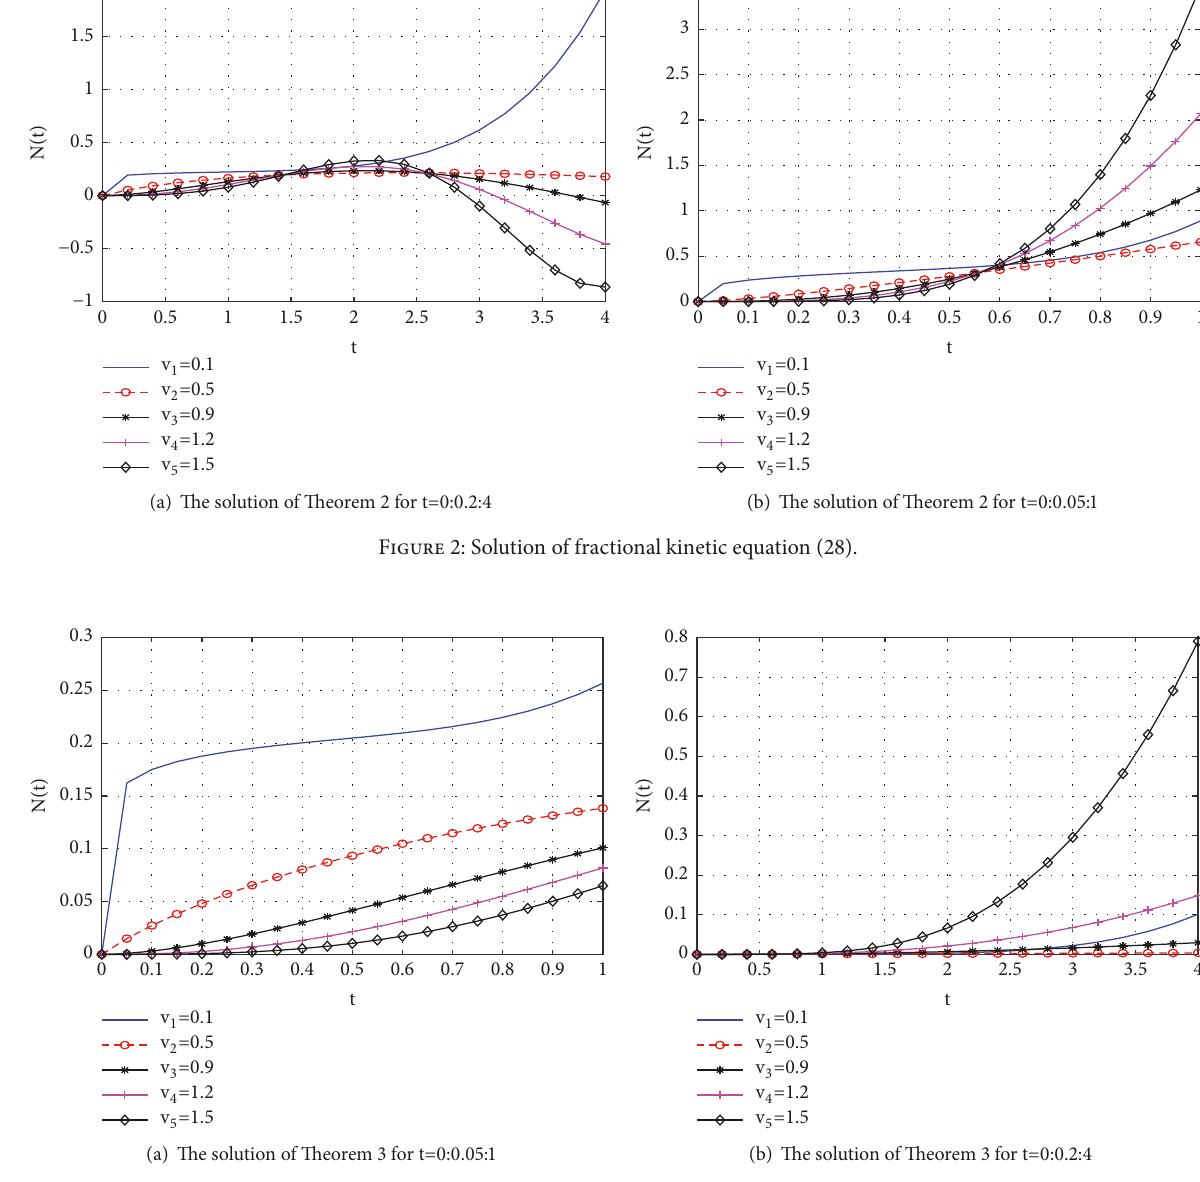
Figure 3: Solution of fractional kinetic equation